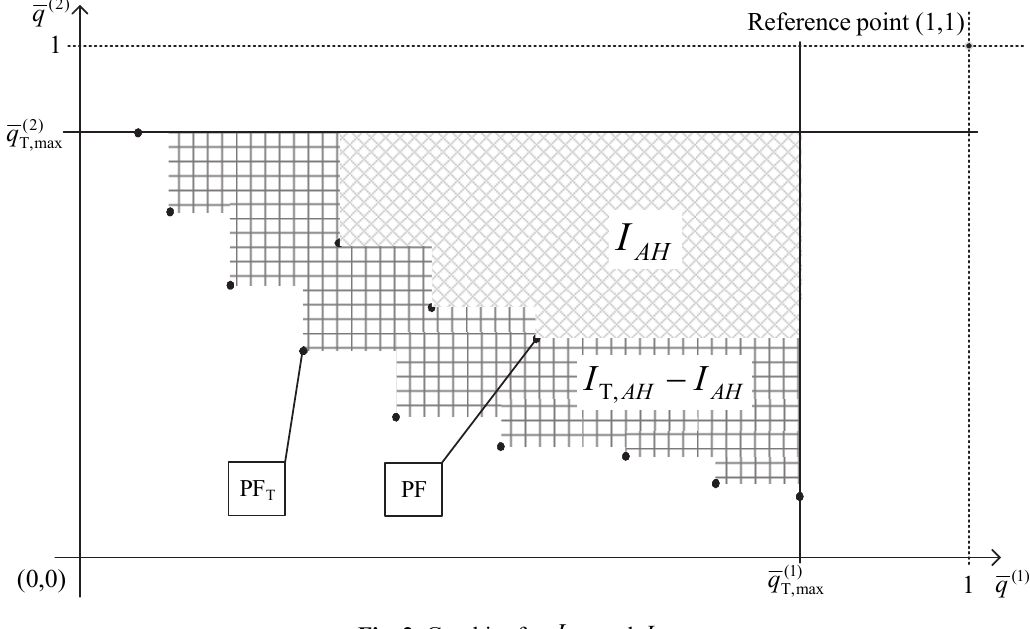
Fig. 2. Graphics for